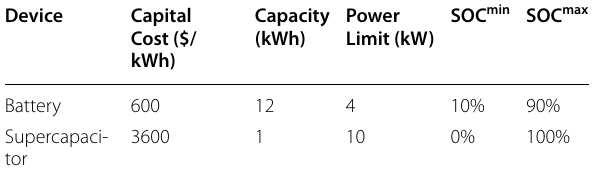
Table 1 Energy storage device